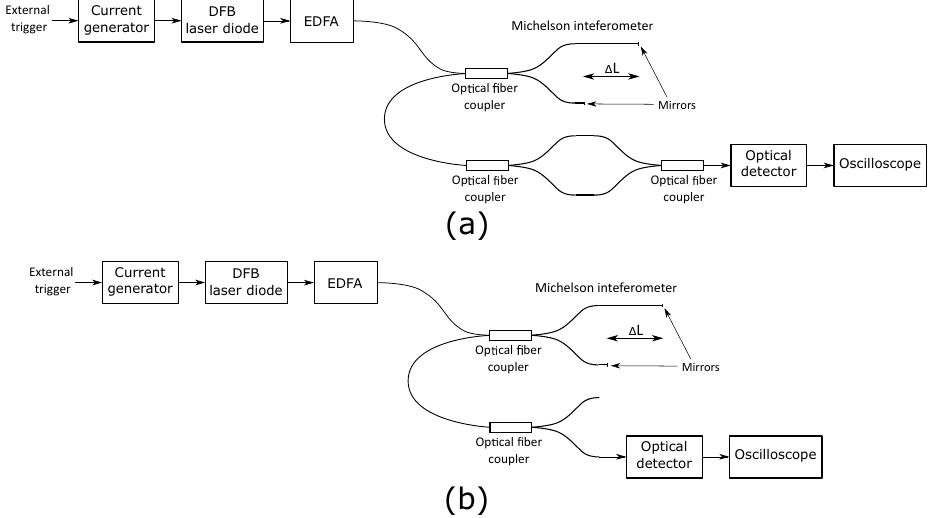
Figure 5. Optical signal evaluation setup for ( a ) time analysis, ( b ) output power analysis.